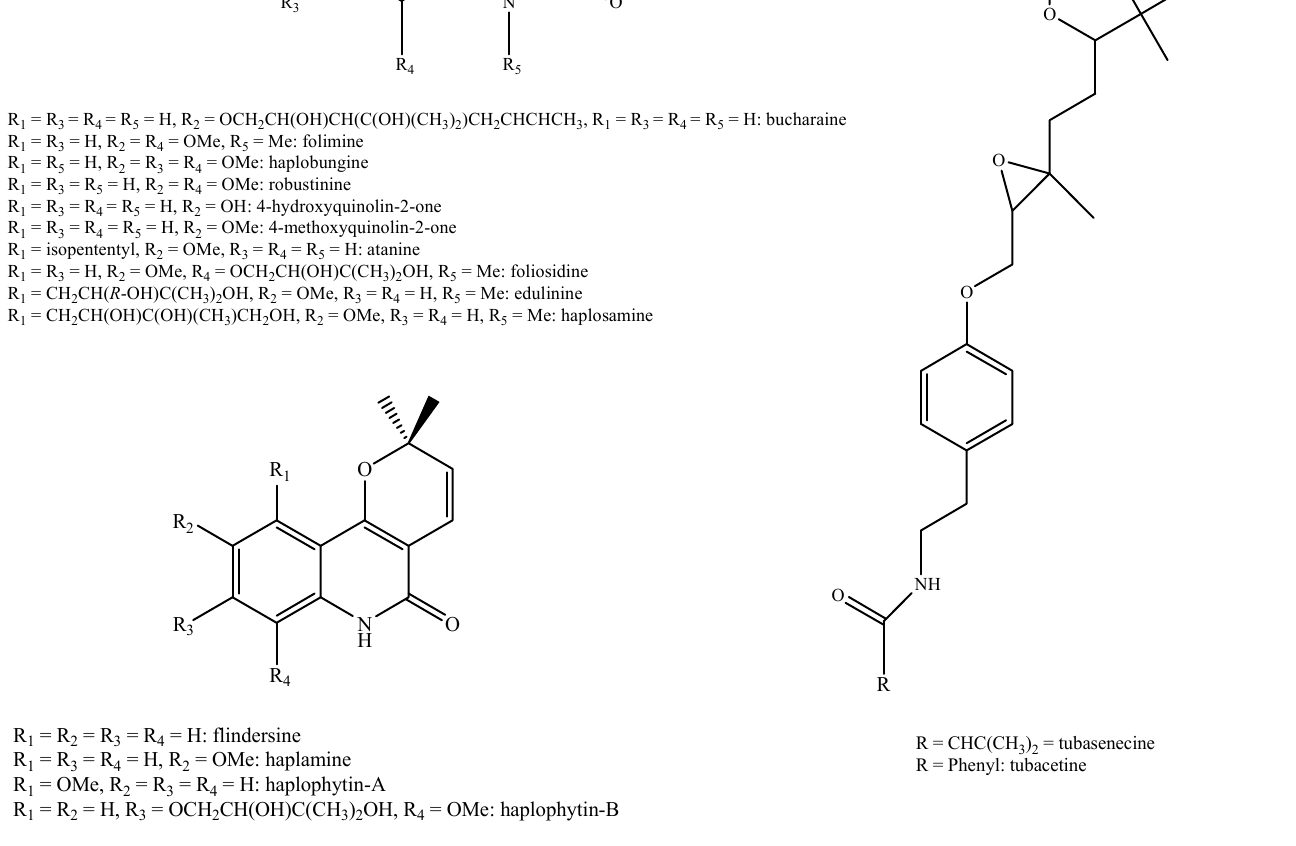
Figure 6. Structure of the alkaloids identified in Haplophyllum species—part 2.